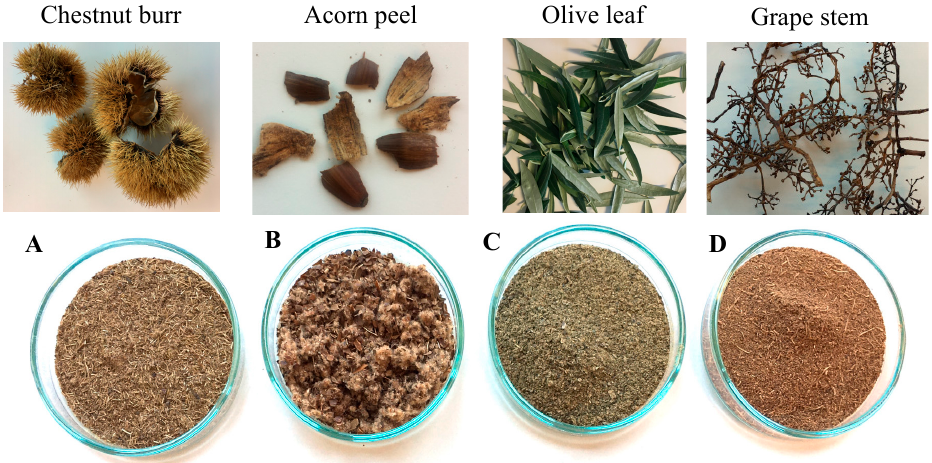
Figure 1. By-products used as plant-based coagulants and their respective powders: ( A )—chestnut burr, ( B )—acorn peel, ( C )—olive leaf, ( D )—grape stem.